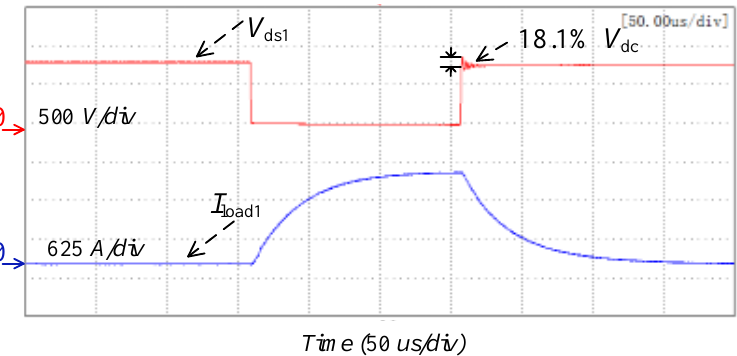
Figure 19. Switching dynamic characteristic test of three-level boost circuit power module.